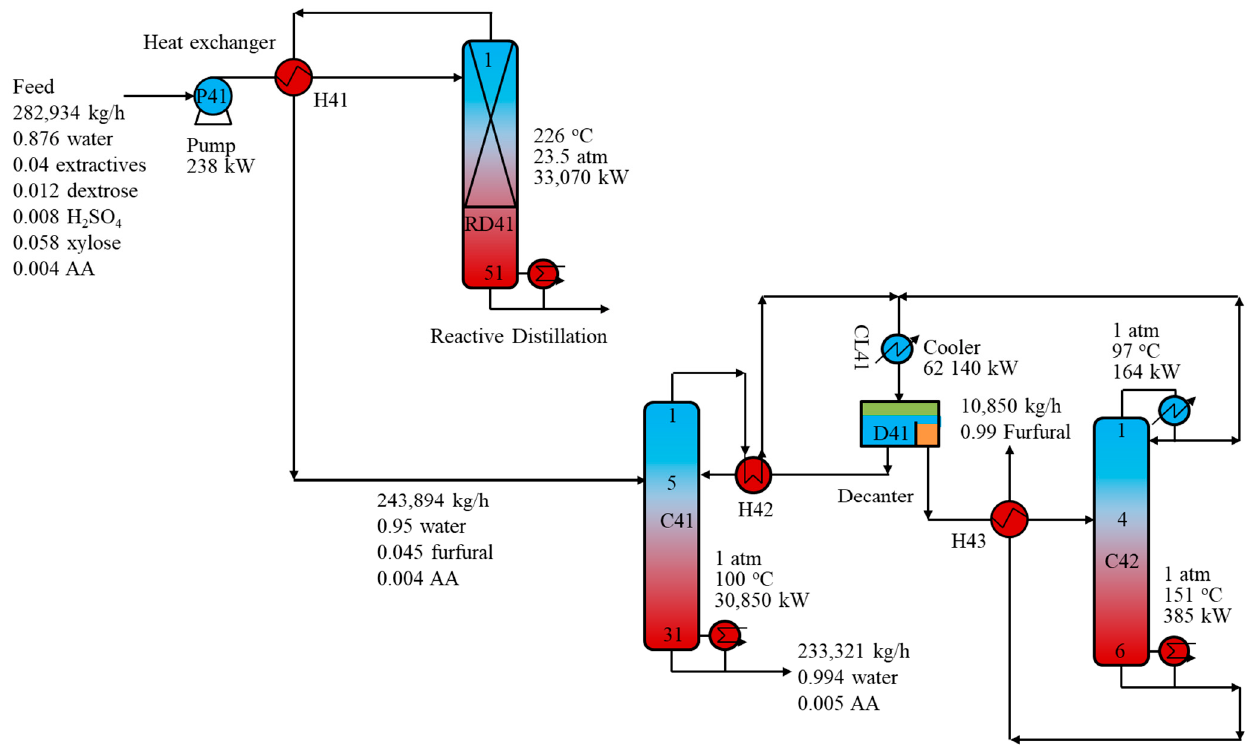
Figure 6. Schematic of the reactive distillation-distillation process for furfural production.